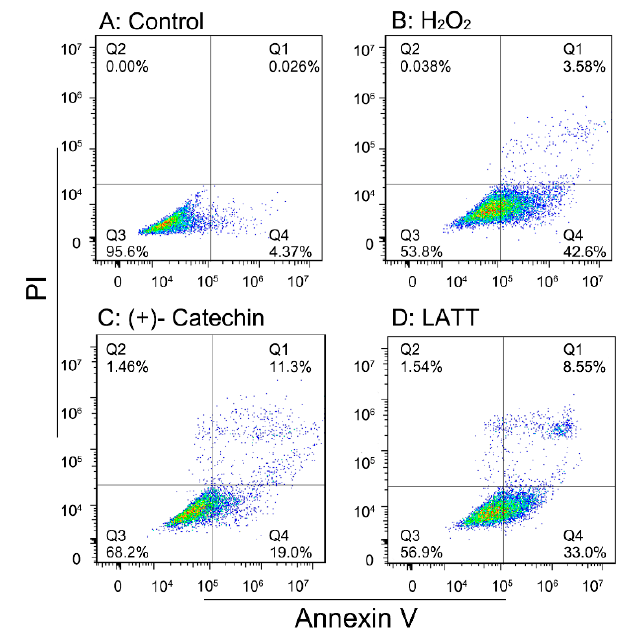
Figure 2. Typical flow cytometry diagram of cytoprotection of (+)-catechin and LATT in oxidatively stressed bmMSCs. The assay was conducted to distinguish live cells ( Q3 ), necrotic cells ( Q2 ), early apoptotic cells ( Q4 ), and late apoptotic/necrotic cells ( Q1 ).